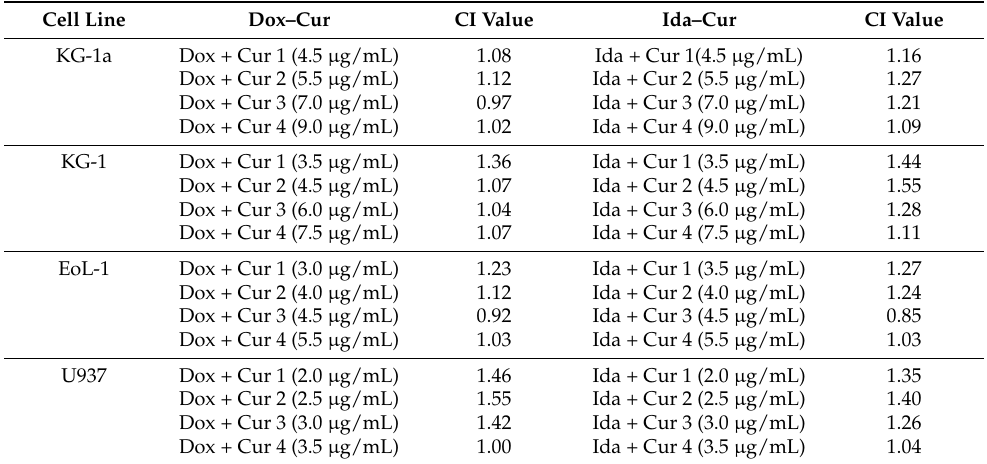
Table 2. IC 50 values of co-treatment of Dox–Cur and Ida–Cur on KG-1a, KG-1, EoL-1, and U937 cells. Cell